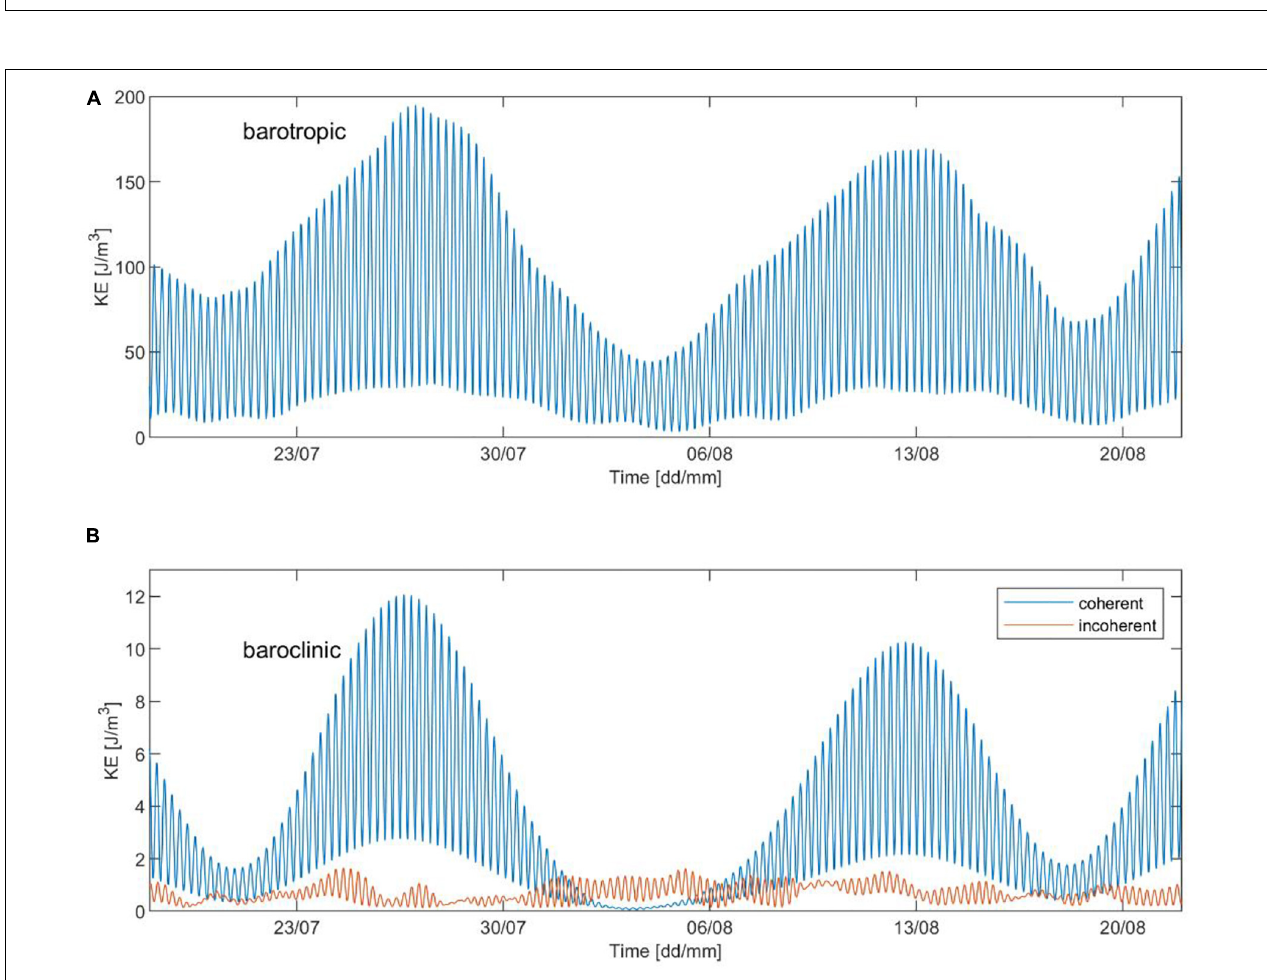
FIGURE 7 | Vertically averaged kinetic energy of the band-passed observed horizontal velocity. (A) The barotropic horizontal kinetic energy. (B) The coherent and incoherent baroclinic horizontal kinetic energy.